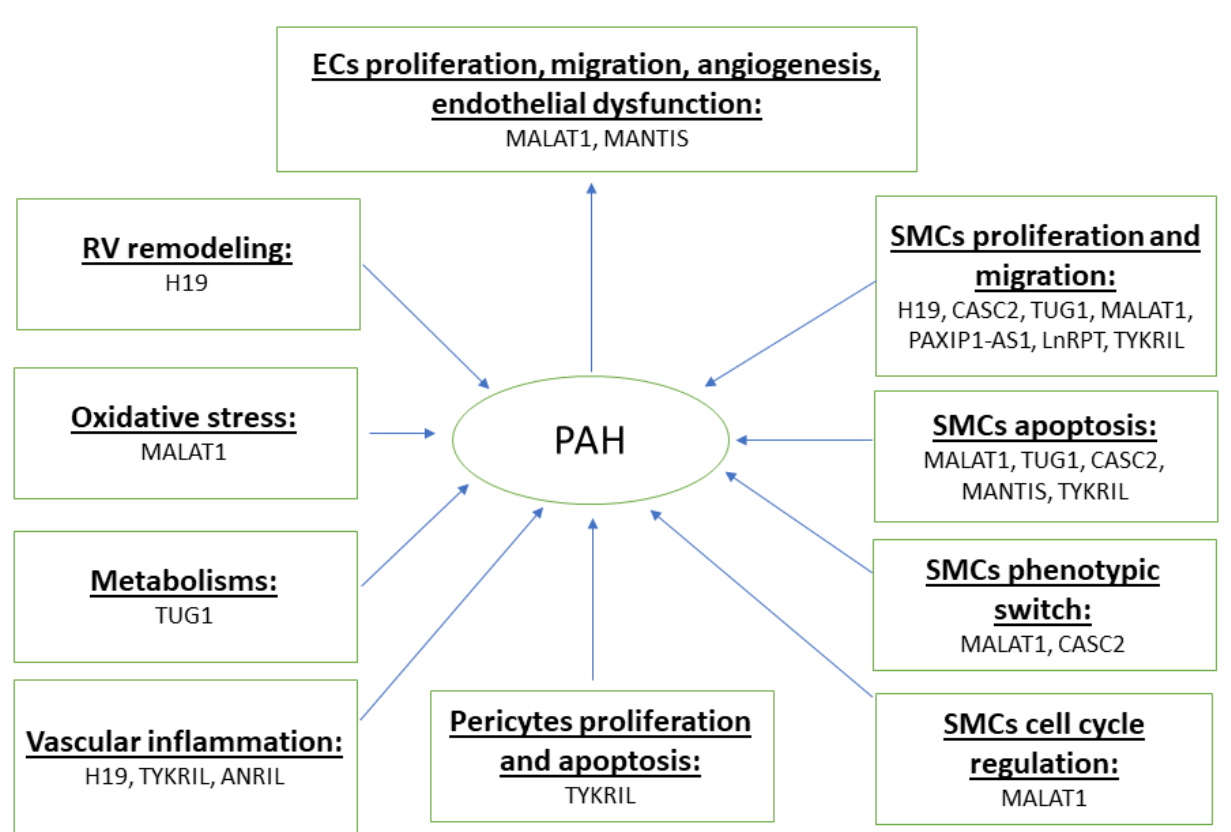
Figure 1. Role of lncRNAs involved in PAH.